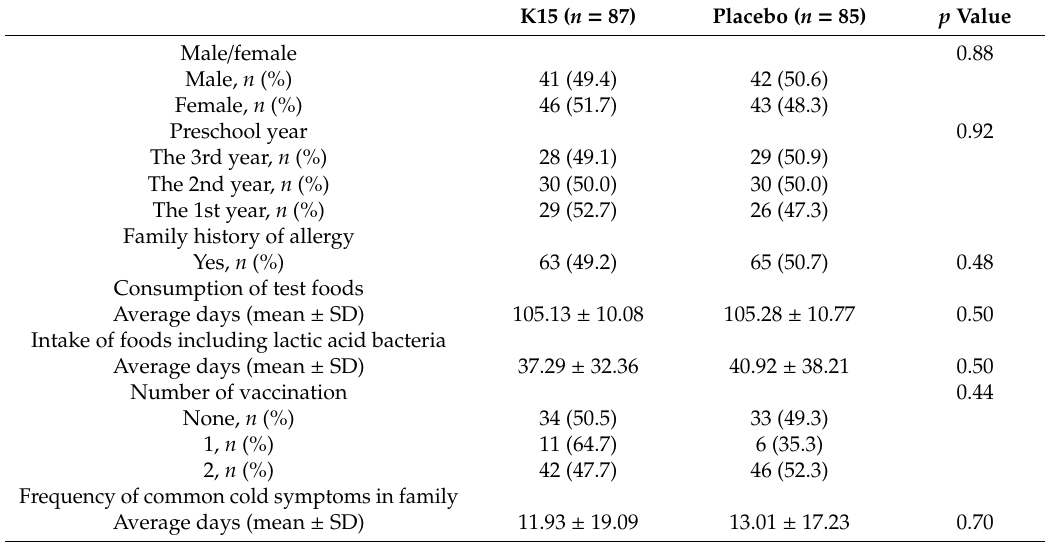
Table 1. Baseline characteristics.